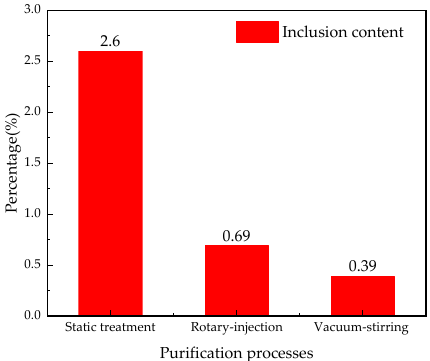
Figure 5. The total inclusion content in three purification processes.